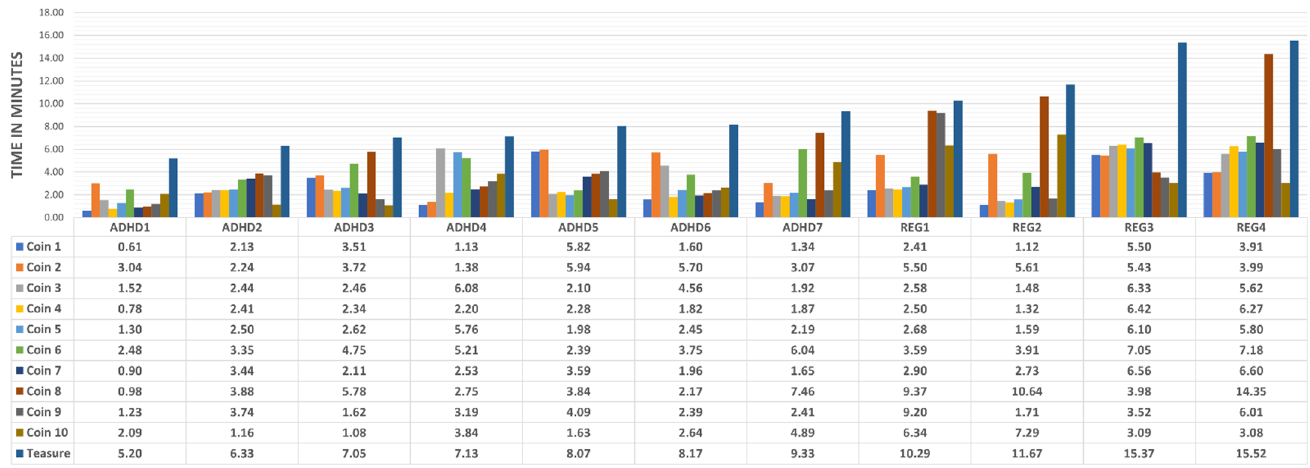
Figure A8. Map of the interactive environment Attention-VR.